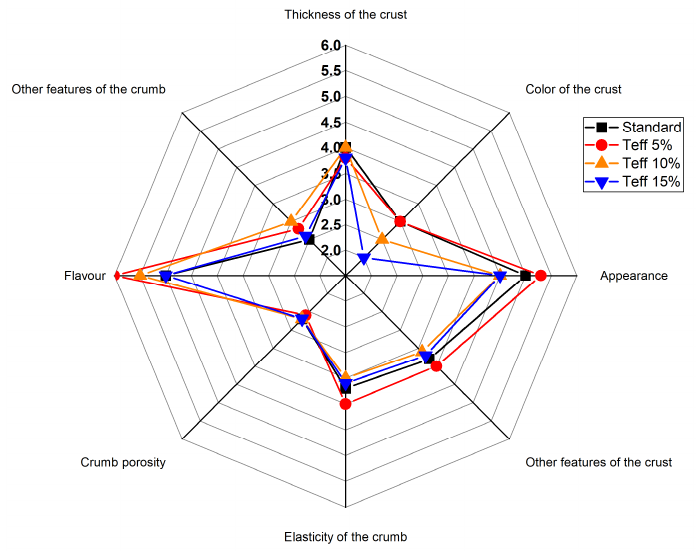
Figure 1. Organoleptic evaluation of the tested bread with teff flour.